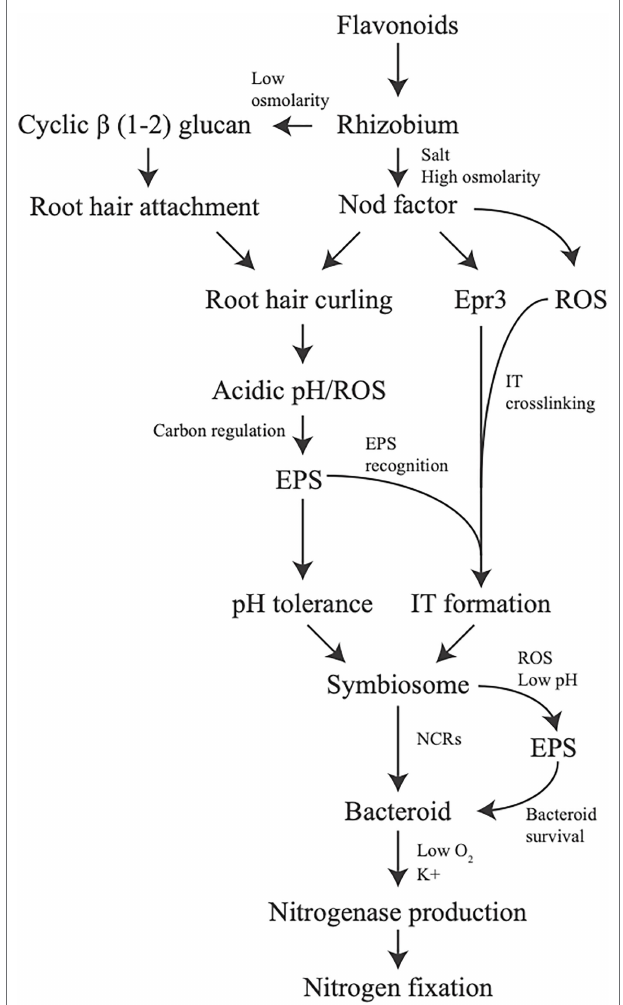
FIGURE 2 | Stress tolerance involvement in symbiotic signaling. Changes in production of molecules or overall physiology due to stress can be observed to affect symbiosis all throughout the process. Each line indicates how a potential stress, or a response from a stress, influences the next step in the symbiotic